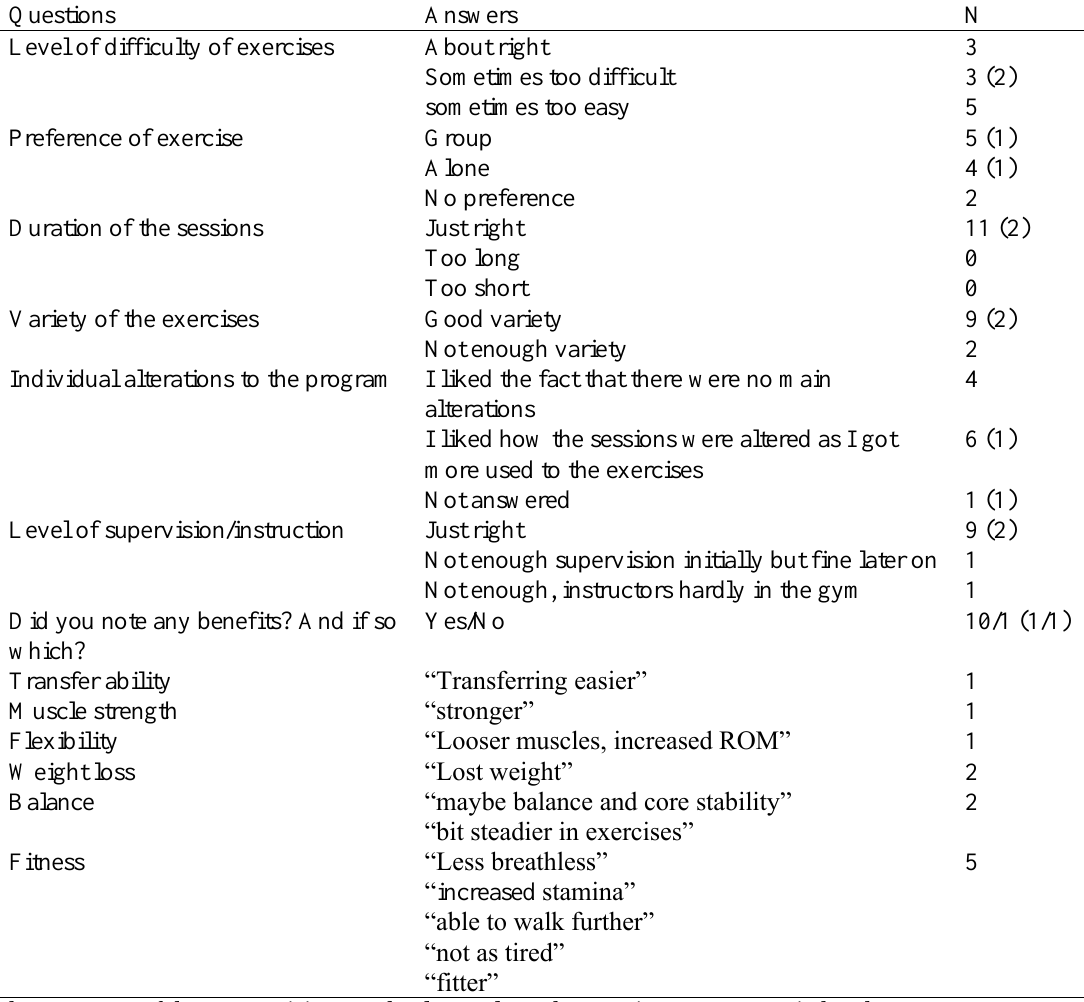
The responses of the two participants who dropped out the exercise program are in brackets. Free text responses are in